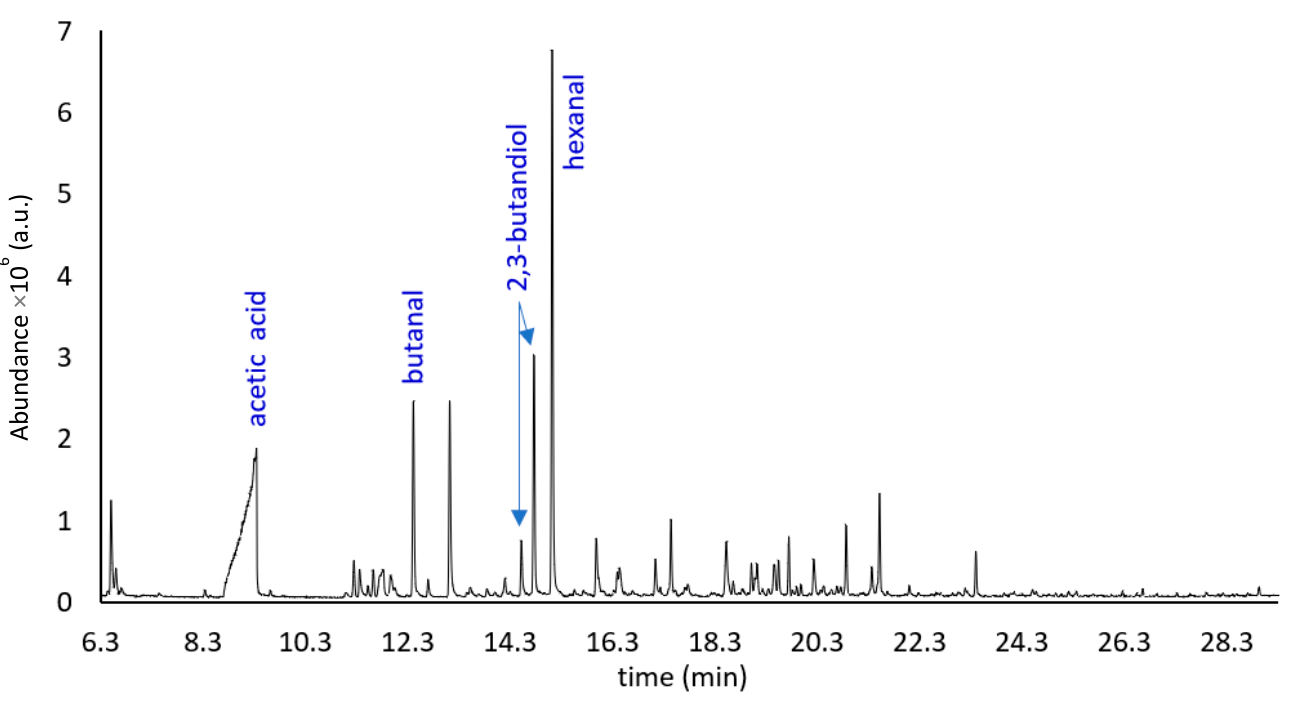
Figure 3. Total ion current chromatogram of the VOCs from M_B_O_t 0 fibrous sample, obtained using HS-SPME-GC-MS (a.u. = arbitrary units). Table 2. VOC composition of bleached melon pomace at t 0 time (M_B_O_t 0 ), identified through HS-SPME-GC-MS analysis, grouped by chemical classes. Data are expressed as mean ( n = 3) TIC area × 10 6 ± SD (3)